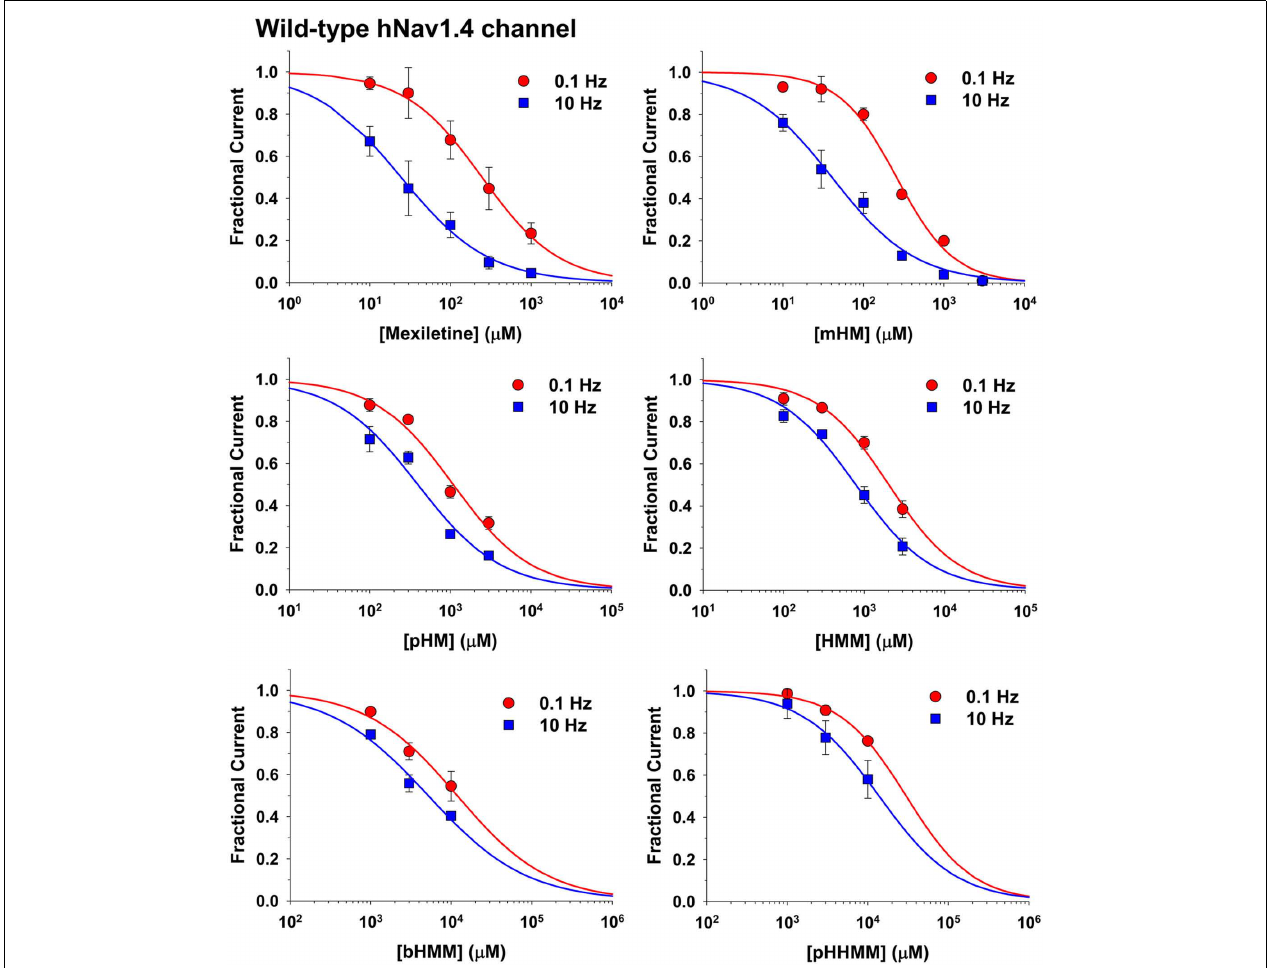
FIGURE 3 | Concentration–response relationships for mexiletine or hydroxylated analogs on hNav1.4 channels. The curves were constructed at 0.1 and 10Hz frequency stimulation, and fitted with a first-order binding